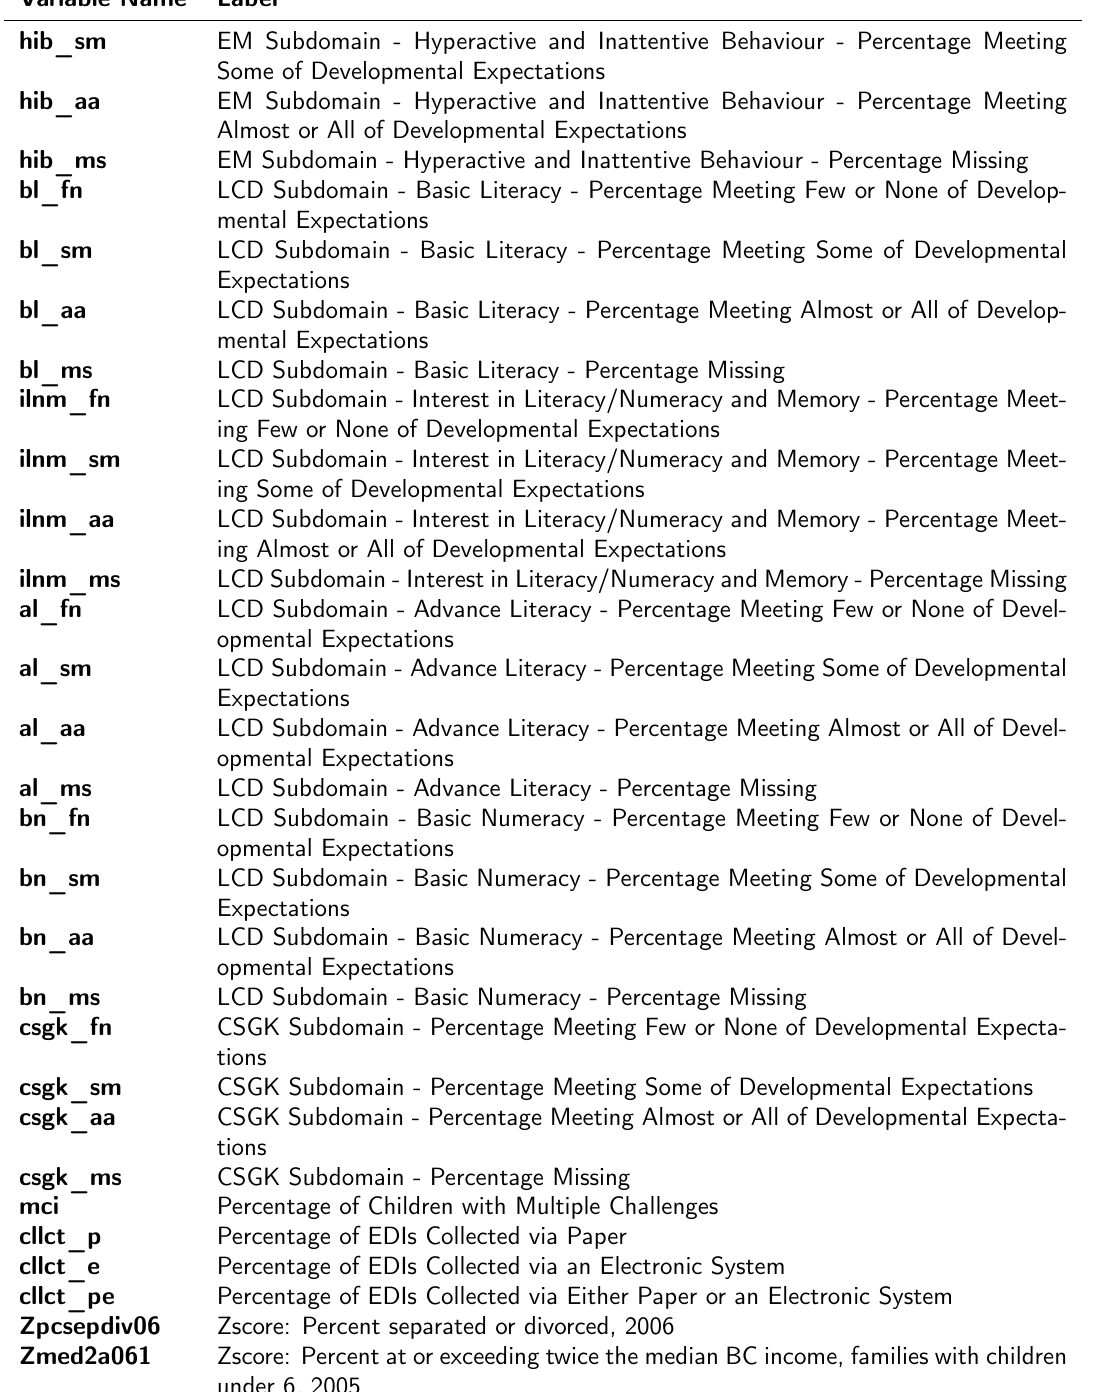
Supplemental Table 1. cont. Early Development Instrument Variables in the CanNECD Database Variable